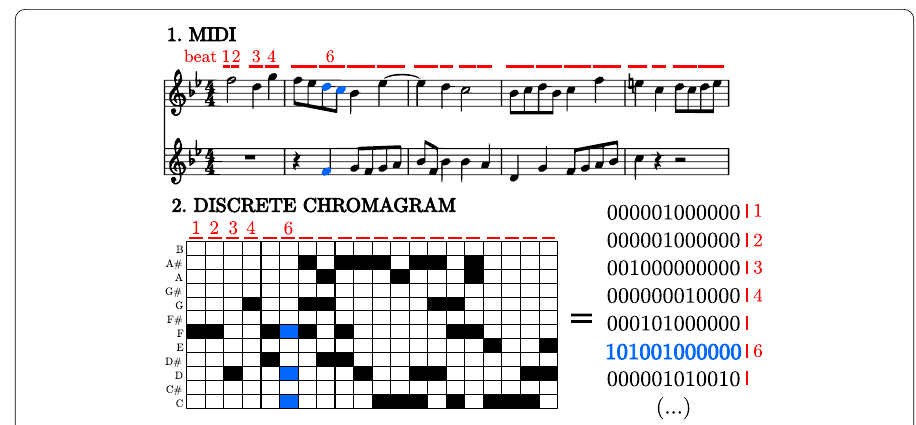
Figure 1 Example of a sequence of discretized chromas (chromagram) arising from a MIDI score. Note that the two pentagrams constituting the score have to be read in